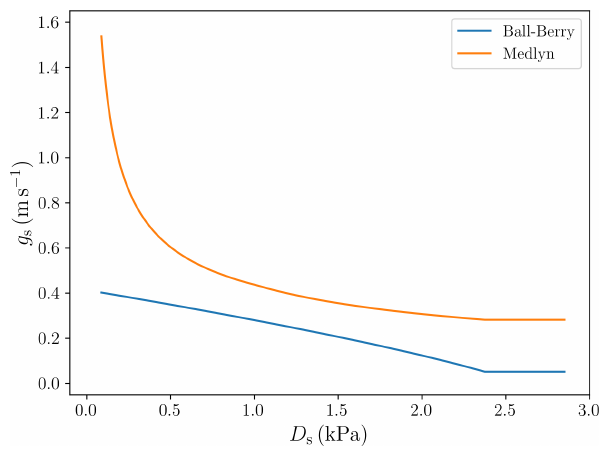
Figure 3. Stomatal conductance as a function of water vapour deficit at the leaf surface.